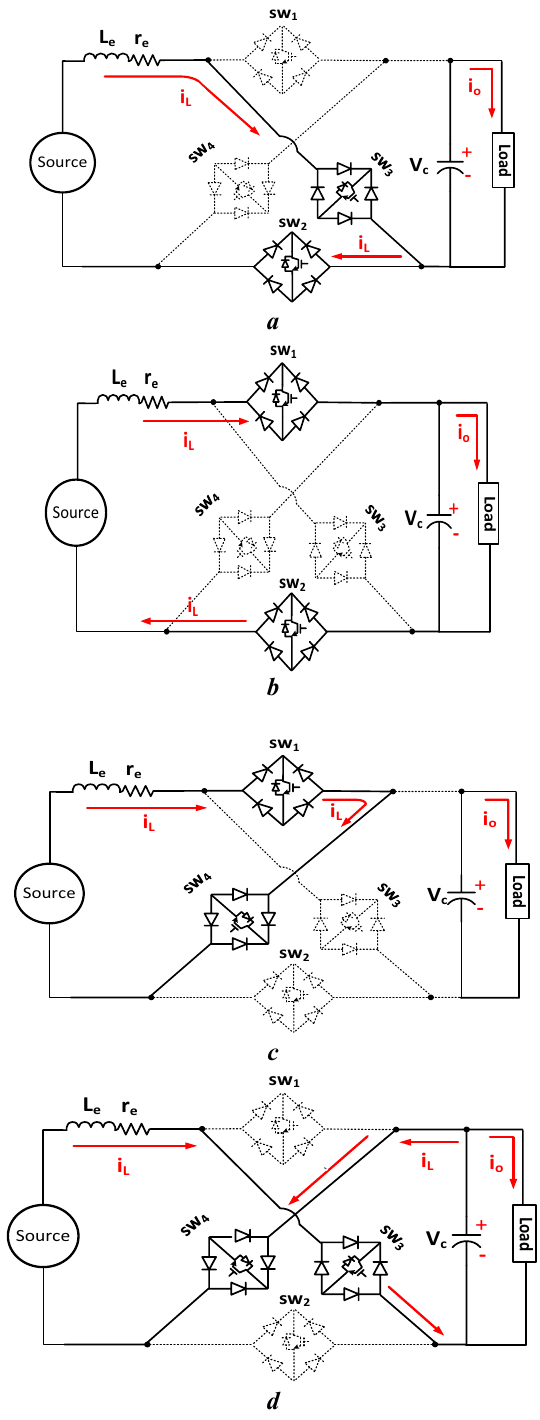
Figure 2. Circuit operation